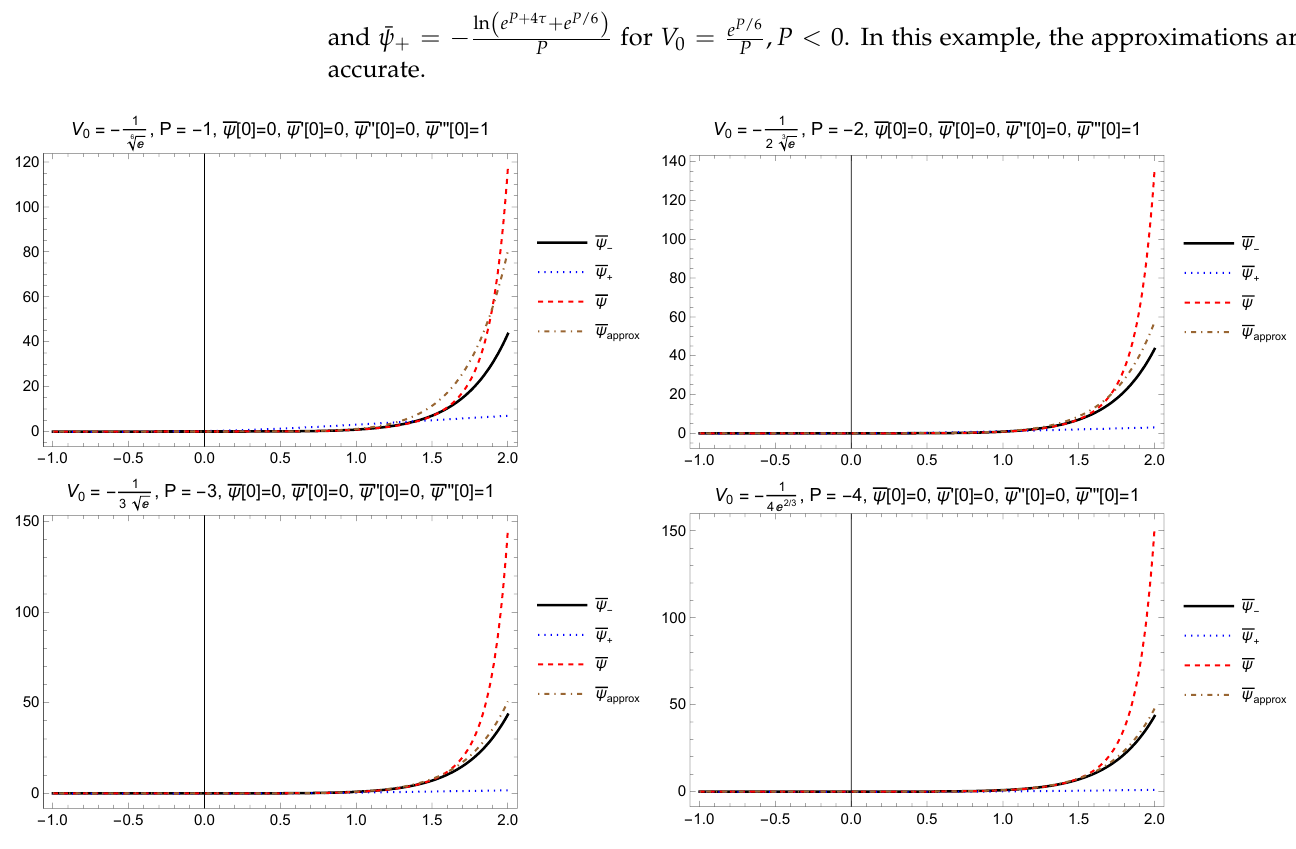
Figure 2. Comparison of exact solution ¯ ψ of (75) with initial conditions ¯ ψ ( 0 ) = 0, ¯ ψ (cid:48) ( 0 ) = 0,